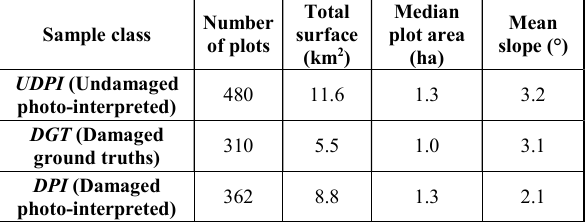
Table 2 . Characteristics of sample classes.